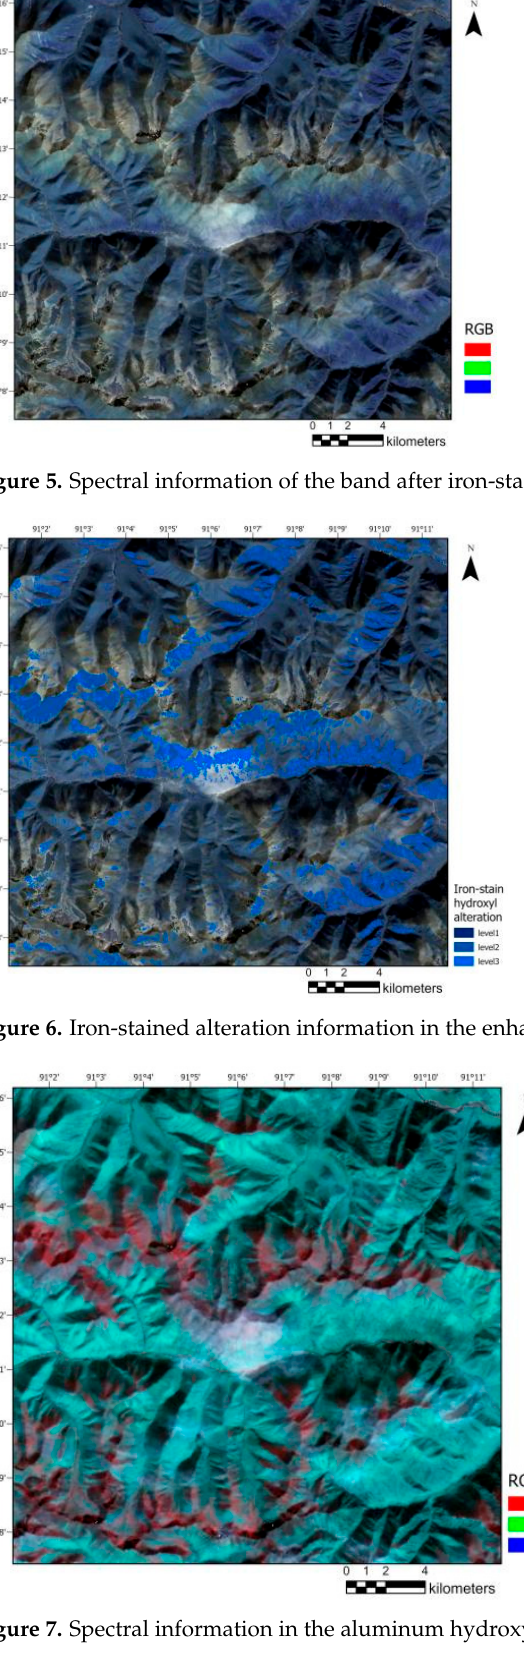
Figure 7. Spectral information in the aluminum hydroxyl-enhanced band.